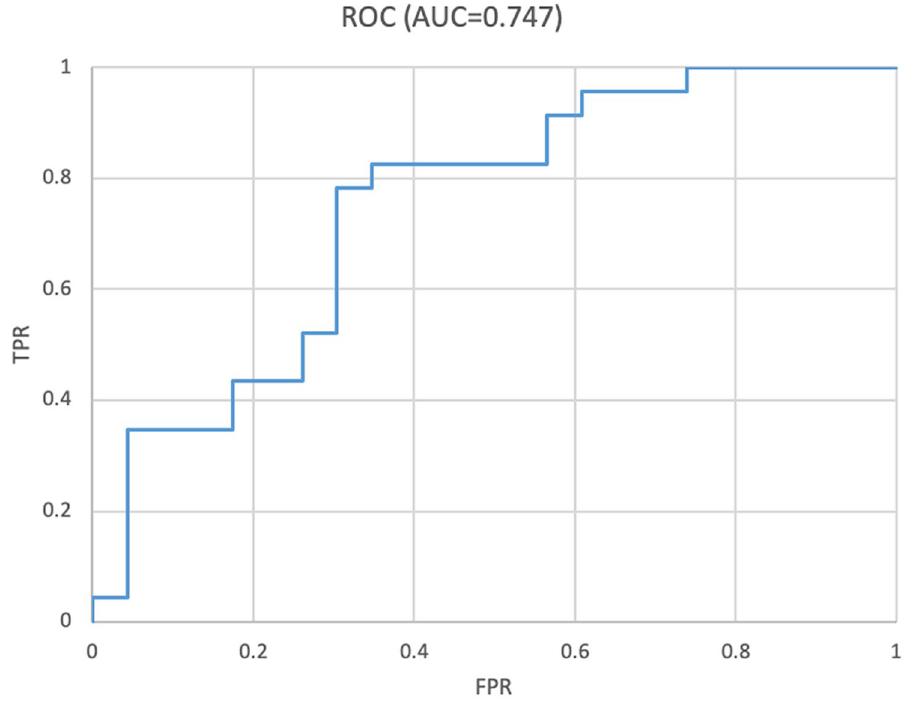
Figure 1. Receiver operating characteristic (ROC) curve for determination. The AUC was 0.746 (95% confidence interval [CI]